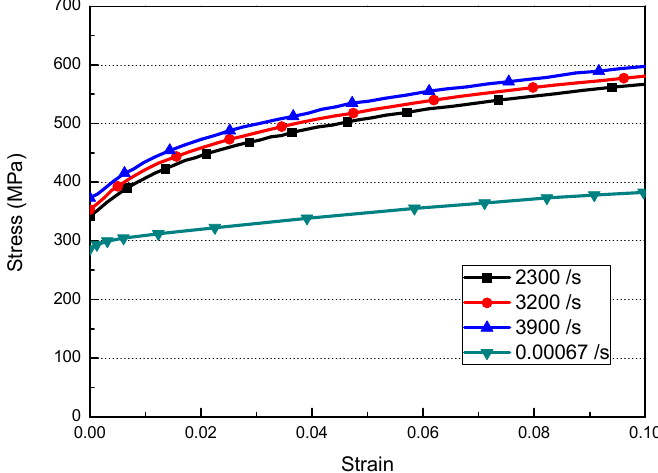
Figure 4. Stress–strain relationship of Al 6061-T6 at quasi-static and high-strain rate conditions.